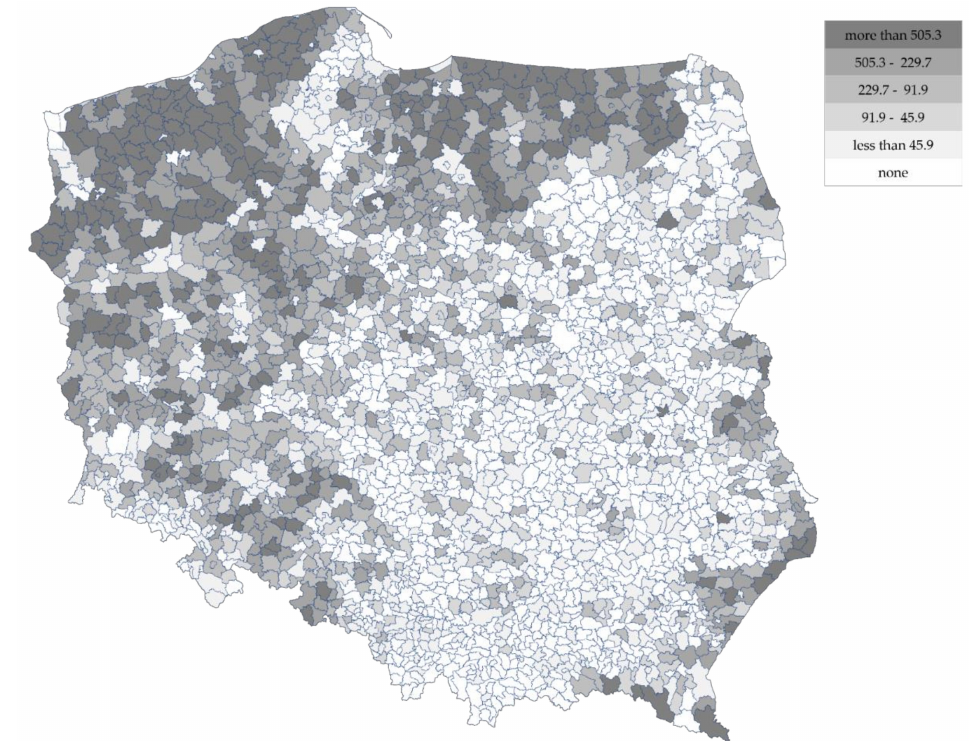
Figure 4. Number of flats sold from state-owned farm resources per 10,000 total population ( W 1 ) in communes. Source: The authors’ calculations based on data of: KOWR and GUS.